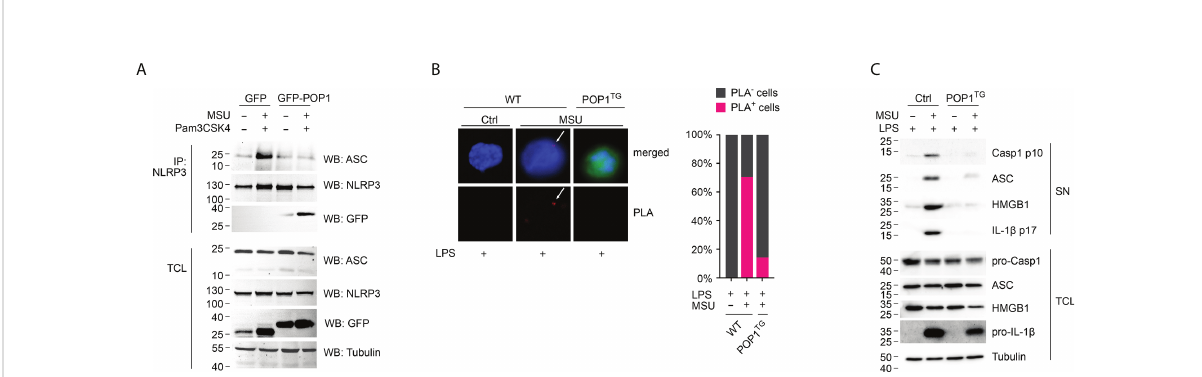
FIGURE 4 POP1 inhibits MSU crystal-induced NLRP3 in fl ammasome assembly and caspase-1 activation. (A) Immunoprecipitation (IP) with immobilized anti-NLRP3 antibodies from either untreated or primed (Pam3CSK4) and activated (MSU crystals) GFP control and GFP-POP1 THP-1 cell lysates as indicated. Immunoblot of IPs and total cell lysates (TCL) for ASC, NLRP3, GFP and as a loading control tubulin. (B) Proximity ligation assay (PLA) between NLRP3 and caspase-1 in LPS primed and MSU crystal activated WT and POP1 transgenic (POP1 TG ) BMDM. DNA (blue), POP1 (green) and an arrow marks the PLA signal (red), showing a representative result (left) and quanti fi cation of PLA + cells of three randomly selected fi elds of views (right). (C) LPS primed WT and POP1 TG BMDM were activated with MSU crystals and culture supernatants (SN), and total cell lysates (TCL) analyzed by immunoblot for active caspase-1 p10, pro-caspase-1, ASC, HMGB1, mature IL-1 b p17, pro-IL-1 b , and tubulin as indicated, showing a representative